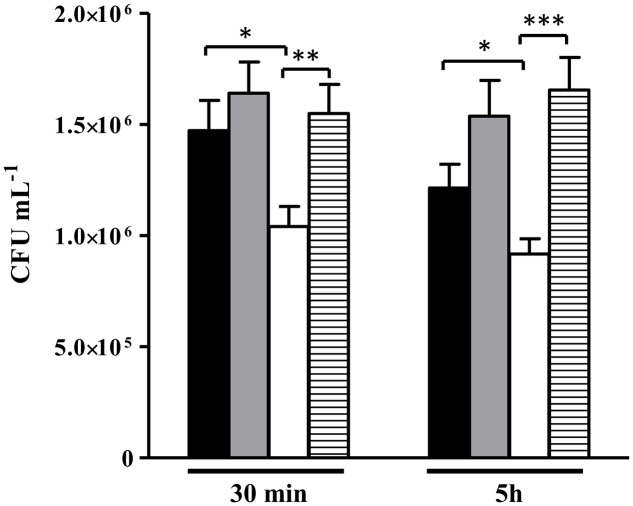
Viability of S. aureus alsS mutant contacting with murine macrophages. S. aureus wild type (black and gray bar) and alsS mutant cells (white and striped bar) were incubated with activated macrophages (black and white bar), and with L-NMMA treated macrophages (gray and striped bar). The number of intracellular S. aureus cells were determined at the indicated times. Error bars represent mean ± SEM (n = 3). Asterisks represent statistically significant data; ∗P < 0.05, ∗∗P < 0.01, and ∗∗∗P < 0.0001.